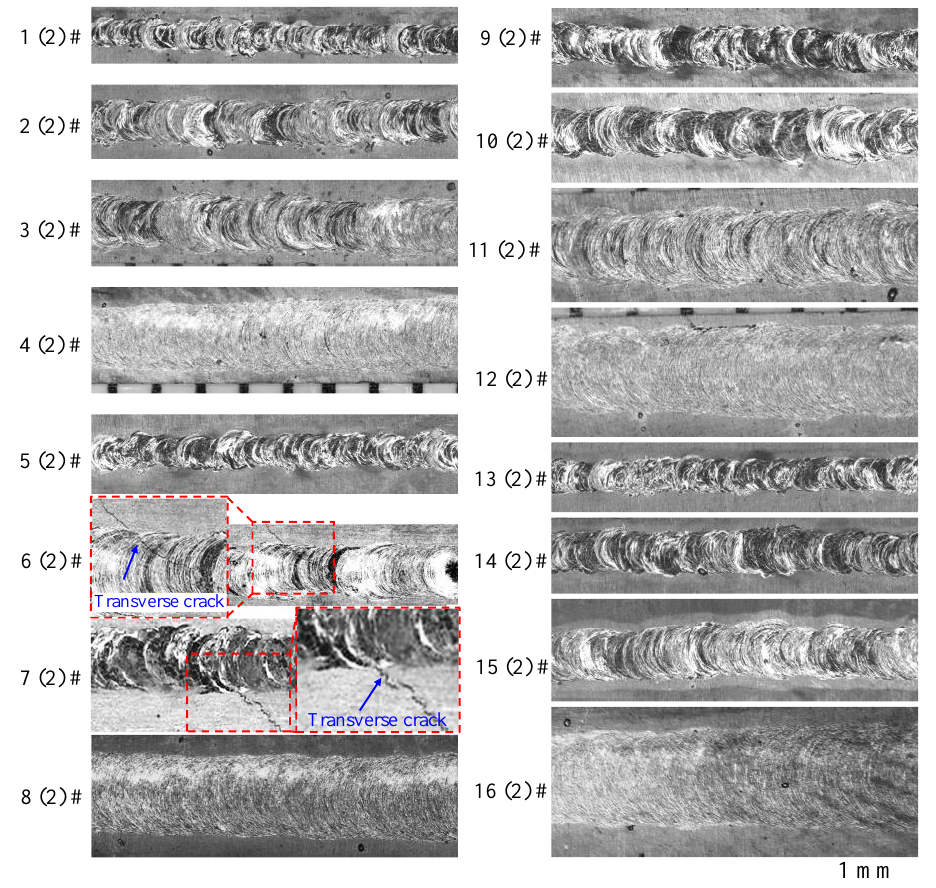
Figure 6. Macroscopic morphologies of the upper surface of the Mo – Re welding joints with a thickness of 2 mm.